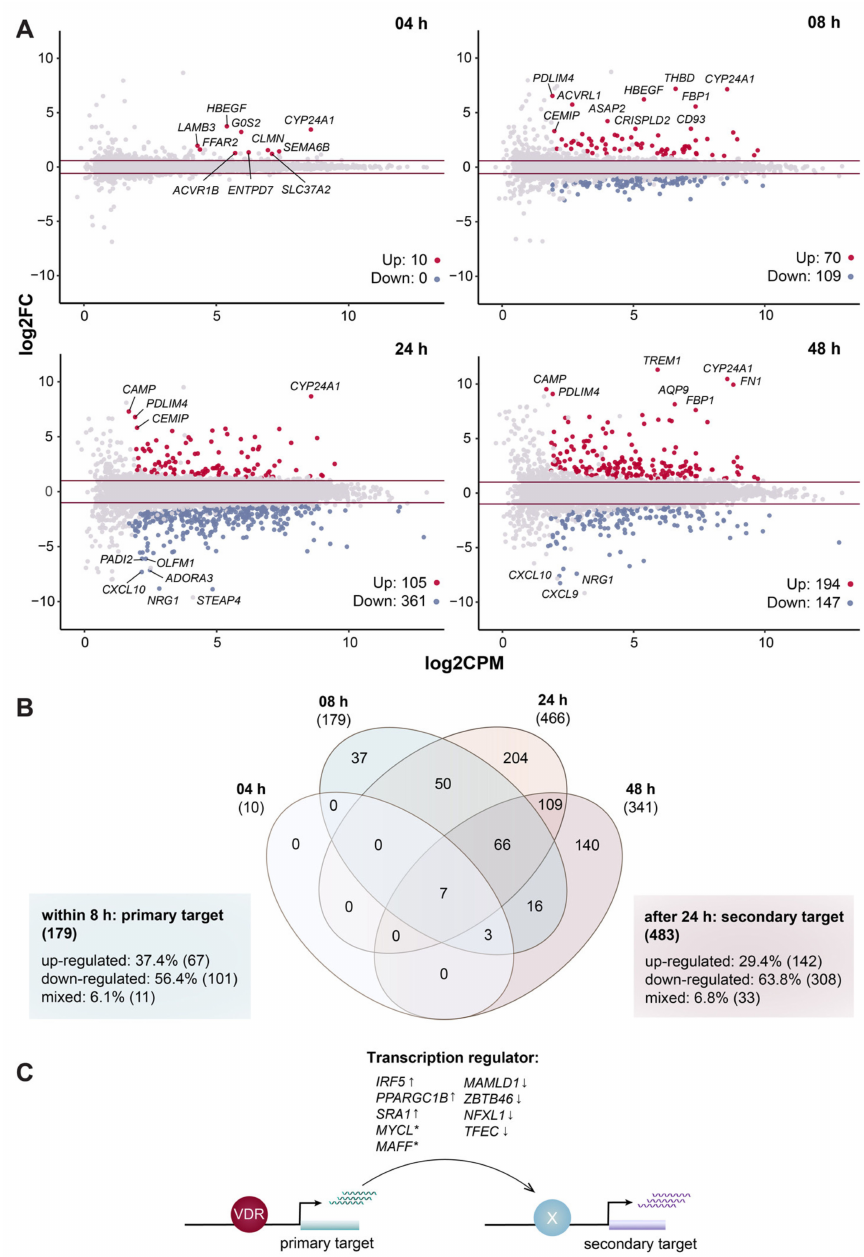
Figure 1. Differential gene expression. Mean-Difference (MA) plots monitor the effects of treatment (10 nM 1,25(OH) 2 D 3 ) at indicated time points in comparison to solvent (0.1% EtOH) ( A ). The statistical test for differential expression was conducted as a pairwise comparison for each time point by using EdgeR’s glmTreat method. The difference in expression change (log2FC) for each tested gene was compared with the mean expression level between the compared groups (log2CPM). Significantly (FDR < 0.05) up- and down-regulated genes are highlighted in red and blue, respectively. At each time point the top 10 genes with highest absolute log2FC are labeled. Horizontal lines (red) indicate the applied statistical testing thresholds (absolute FC > 1.5 at 4 and 8 h and absolute FC > 2 at 24 and 48 h). A Venn diagram displays the in total 662 genes identified at different time points ( B ). Genes responding already at the early time points (4 and 8 h) are considered as primary targets. The direction of regulation of a gene over all time points was determined by applying a FC threshold of 1.5. The classic model of vitamin D signaling suggests that primary target genes encoding for the indicated transcriptional regulators mediate the activation or repression of secondary targets ( C ). Asterisks (*) denote genes with mixed FC profiles. Arrows indicate transcription start